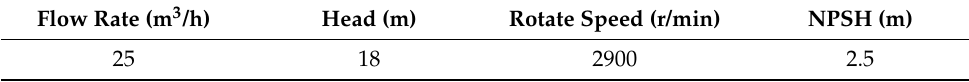
Table 1. Design requirement of centrifugal pump.